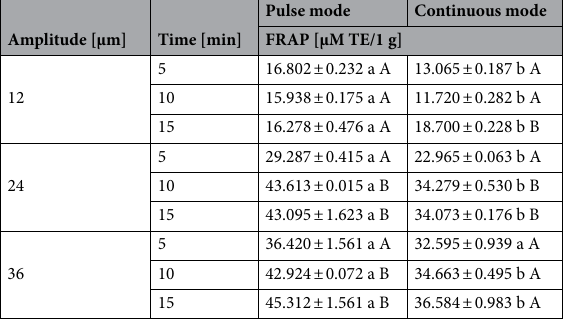
Table 2. FRAP values in individual extracts. a, b—different letters show statistically significant differences in Tukey’s test in row (< 0.05). A, B—different letters show statistically significant differences in Tukey’s test in column for one amplitude (<